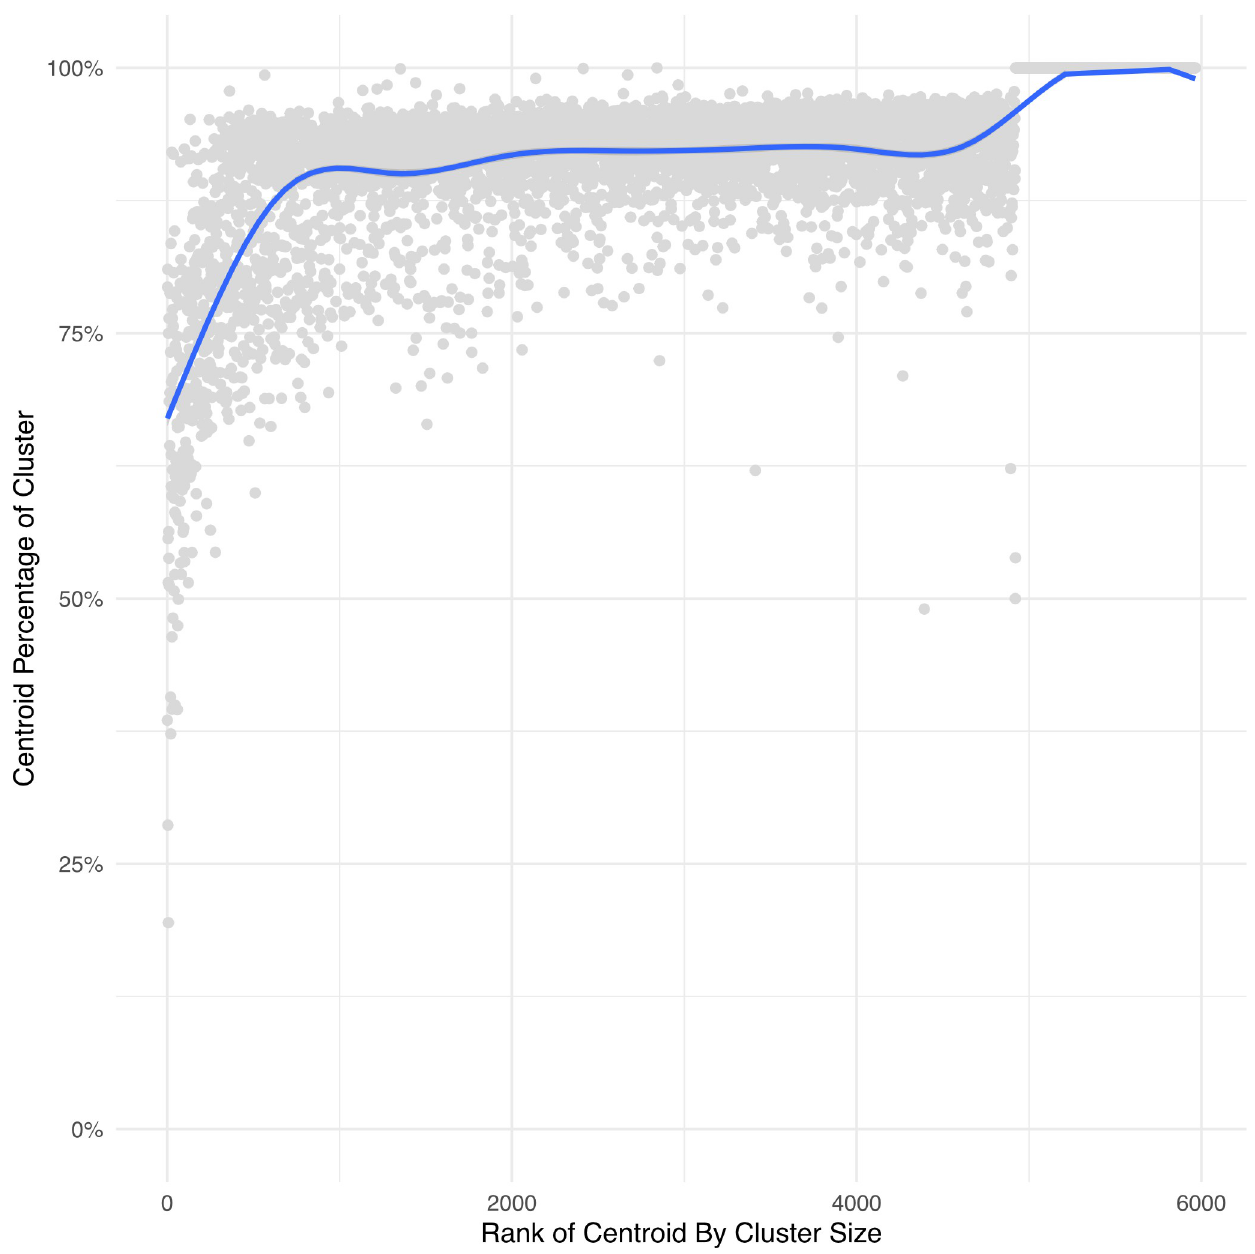
Fig 6. Centroid counts as percentage of cluster counts. Each gray dot represents the percentage of counts in a cluster (using L3 clustering) from the plasmid library that comes from its centroid. The centroids are ordered by the size of their cluster. The highest-count cluster is ranked 1. A smoothed curve (in blue) is fitted to the dot plot. This plot shows that the majority of cluster counts come from the defined